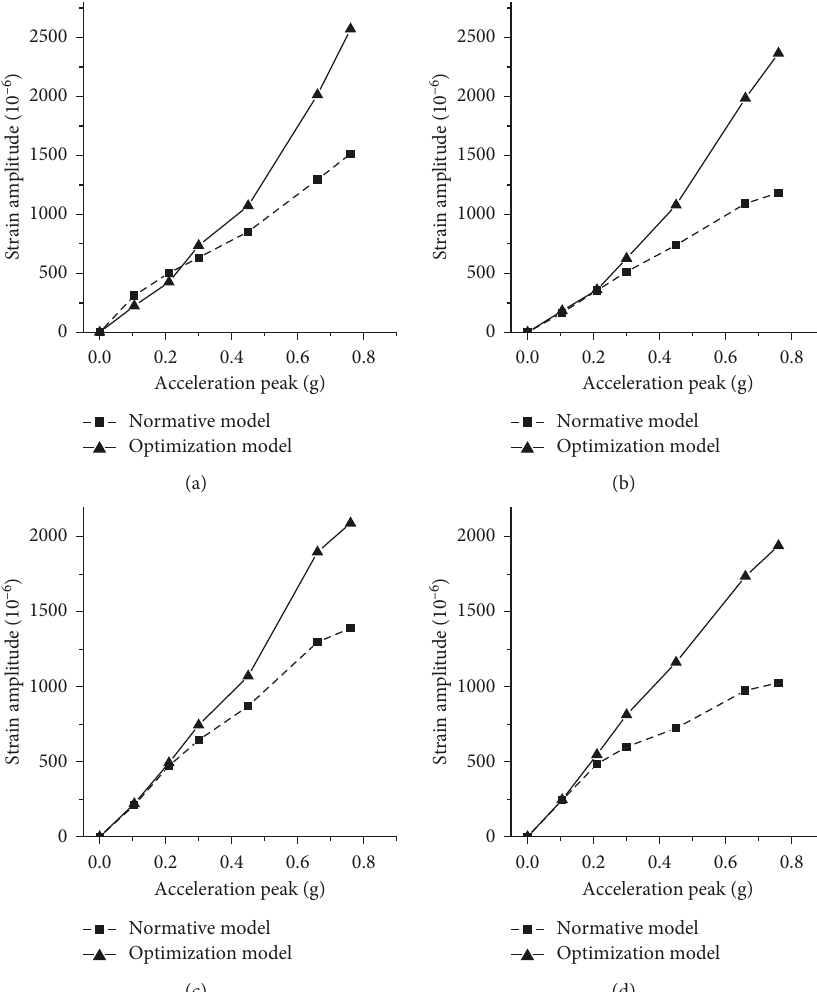
Figure 8: Damage evolution of horizontal component. (a) Coupling beam at 8 story, (b) coupling beam at 11 story, (c) frame beam at 8 story, and (d) frame beam at 11 story.